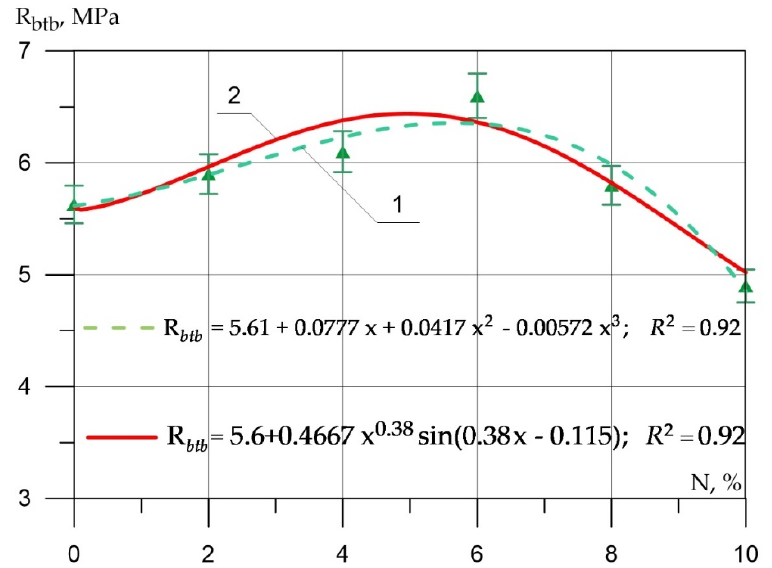
Appl. Sci. 2022 , 12 , x FOR PEER REVIEW 13 of 18 Figure 10. Results of experimental studies of the effect of dosage of rice straw biochar on flexural tensile strength: 1—polynomial of the 3rd degree; 2—function (1).